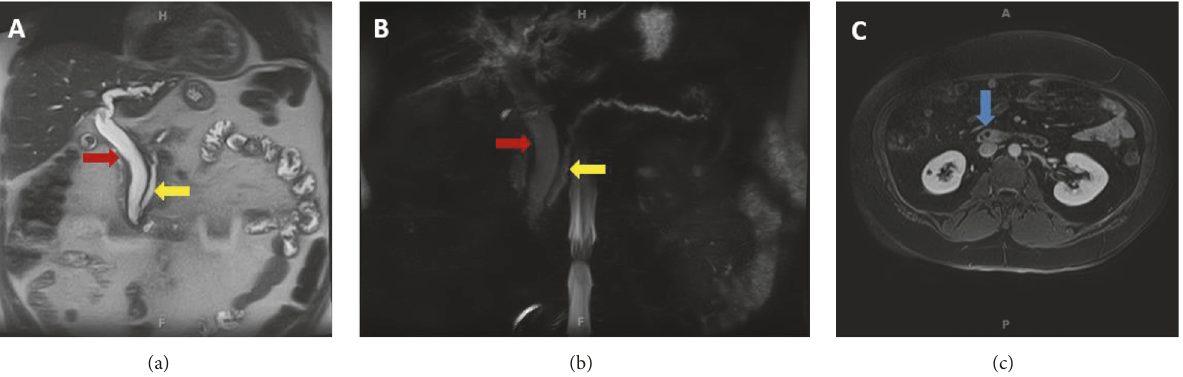
Figure 1: MRI abdomen with and without contrast: (a) T2 image and (b) MRCP image reveal moderate to severe intrahepatic biliary ductal dilation. The common duct measures 1.5 cm in greatest diameter “red arrow”. The pancreatic duct is also dilated measuring up to 0.6 cm at the head “yellow arrow”. No intraluminal filling defect. (c) T1 image with contrast reveals mild distal common bile duct wall enhancement “blue arrow”.